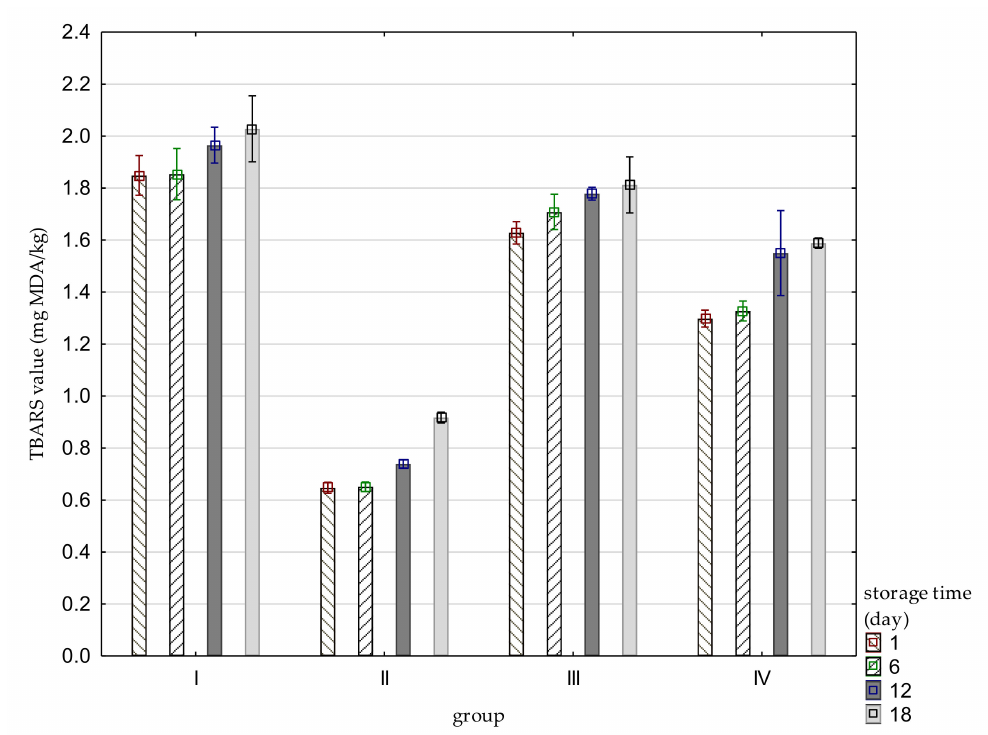
Figure 1. TBARS (mg MDA/kg) value in duck burgers during refrigerated storage. ( p -value in subsequent measurements: group I ≤ 0.001; group II ≤ 0.001; group III ≤ 0.001; group IV ≤